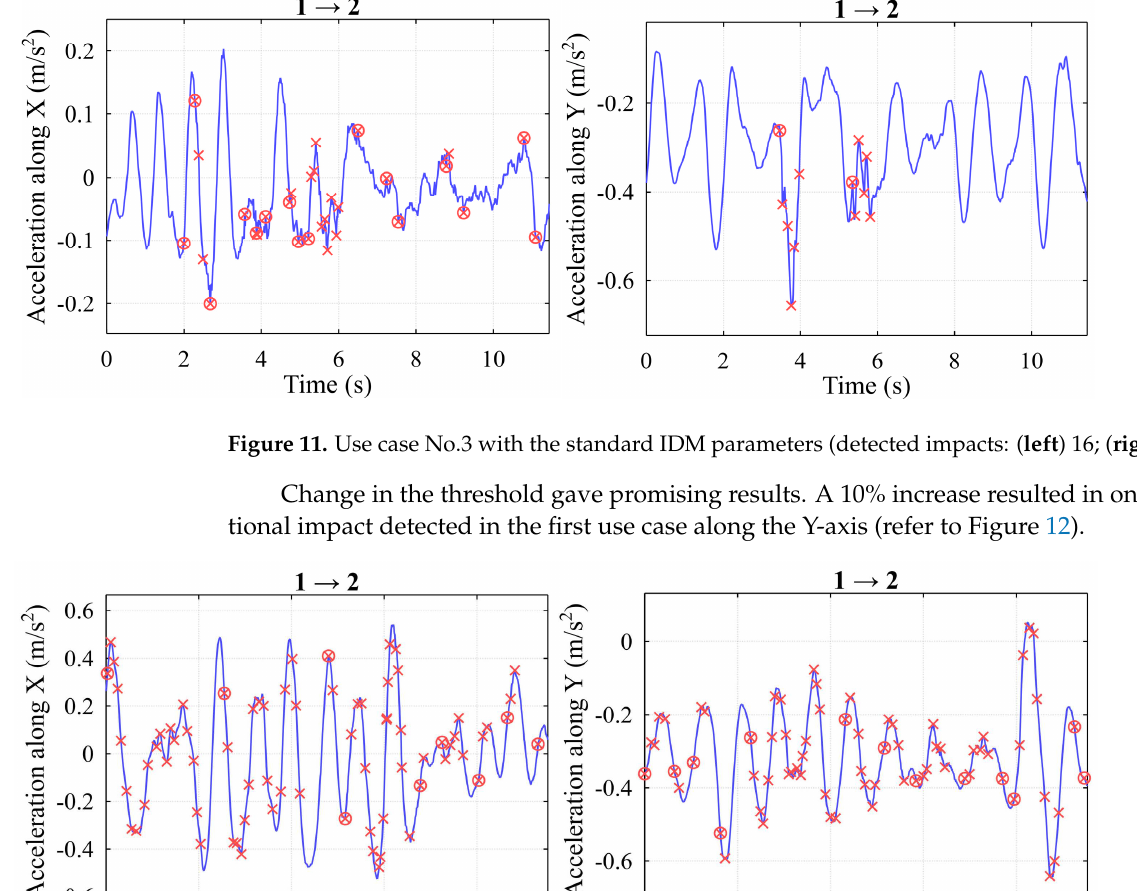
J. Mar. Sci. Eng. 2022 , 10 , x FOR PEER REVIEW